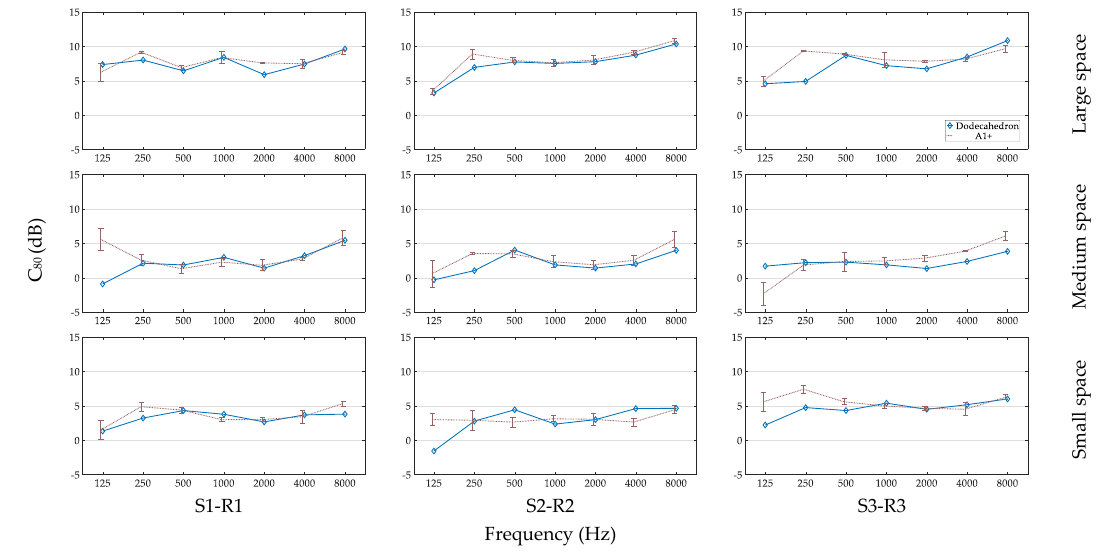
Figure 11. C 80 measurements at three positions for three different spaces (i.e., large, medium, small). Error bars represent measured standard deviation.